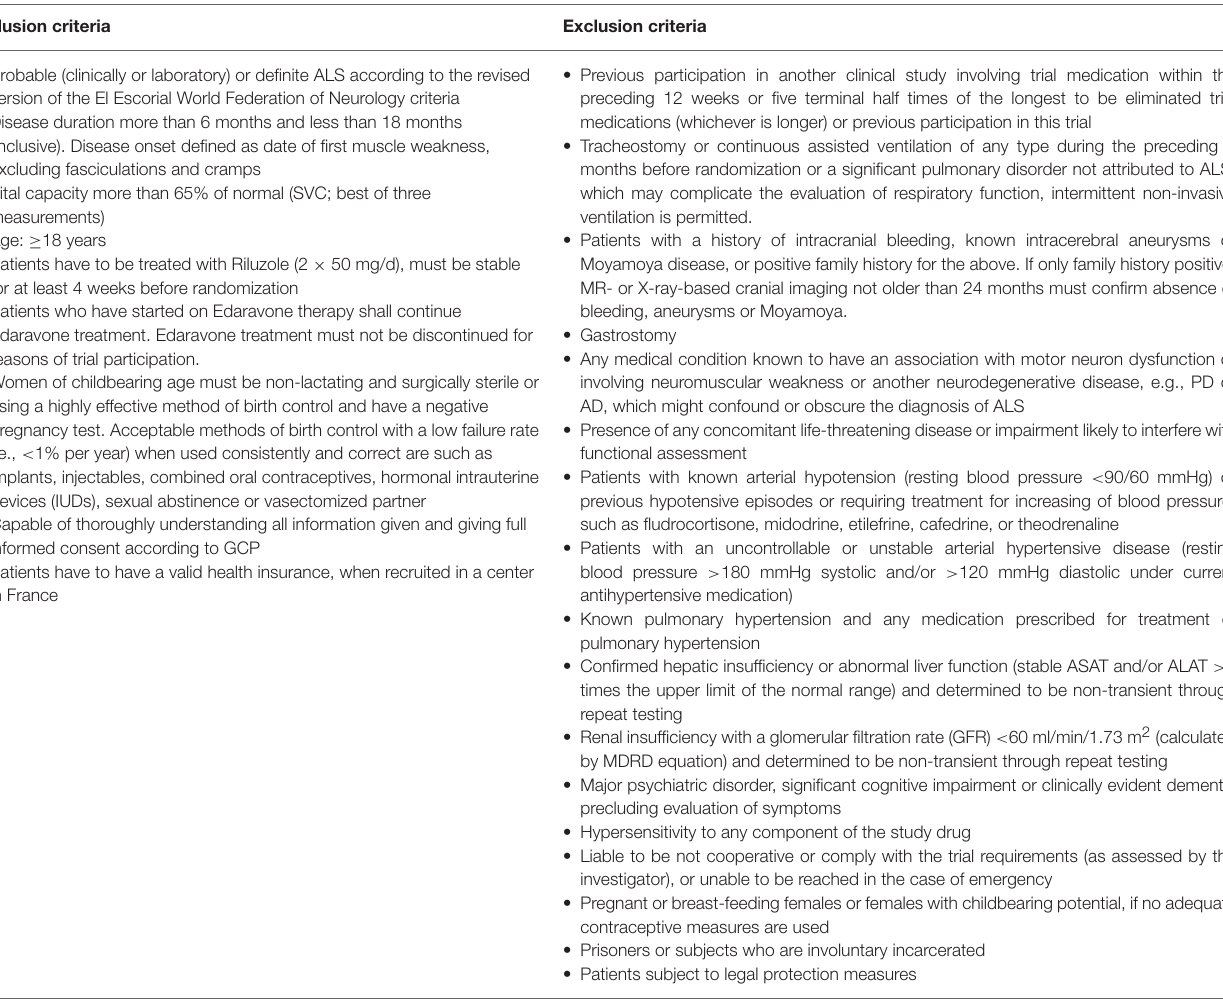
TABLE 1 | Inclusion and exclusion criteria. Inclusion criteria Exclusion